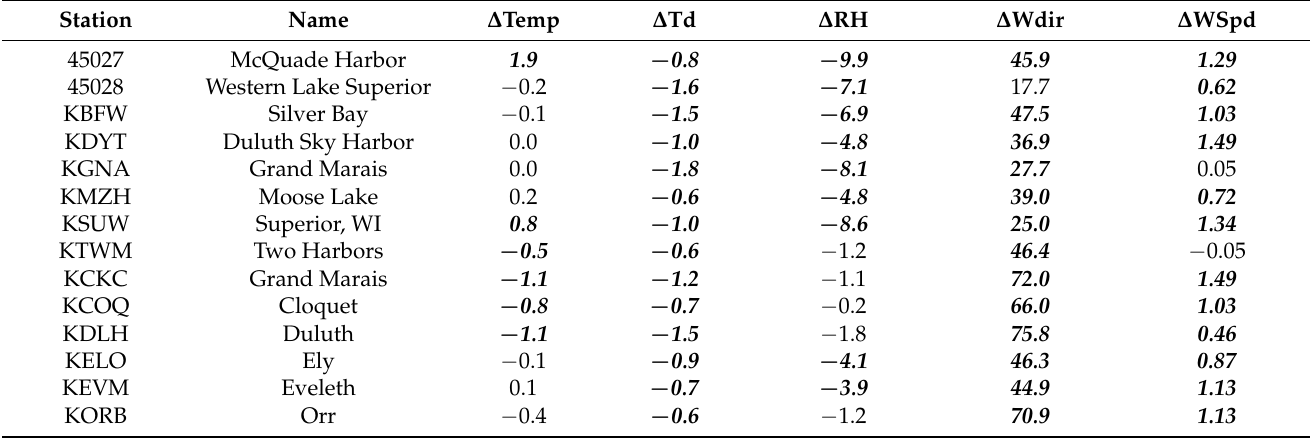
Table 3. Average changes ( ∆ ) experienced over all cold fronts at each of the stations examined. Temp = temperature ( ◦ C); Td = dewpoint ( ◦ C); RH = relative humidity (%); Wdir = wind